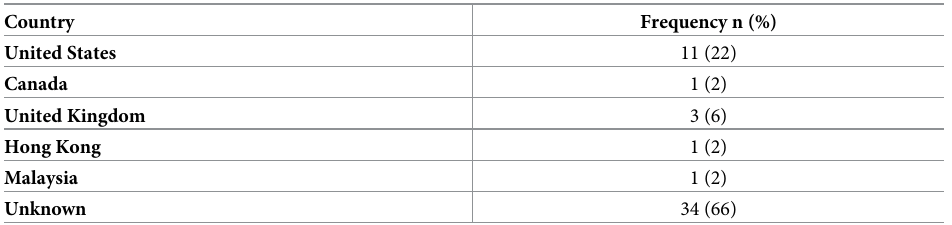
Table 1. Country of post origin of the post or user account (n =